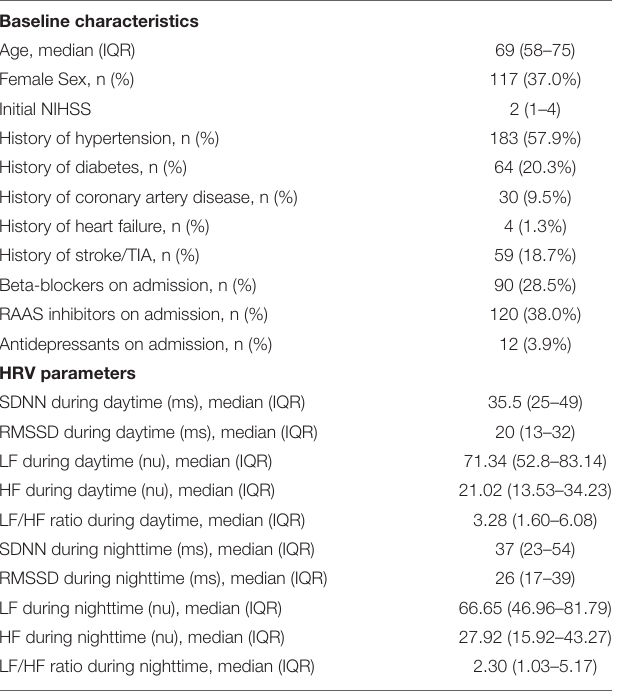
TABLE 1 | Baseline characteristics and HRV parameters of 308 HEBRAS patients included in the analysis. Baseline characteristics